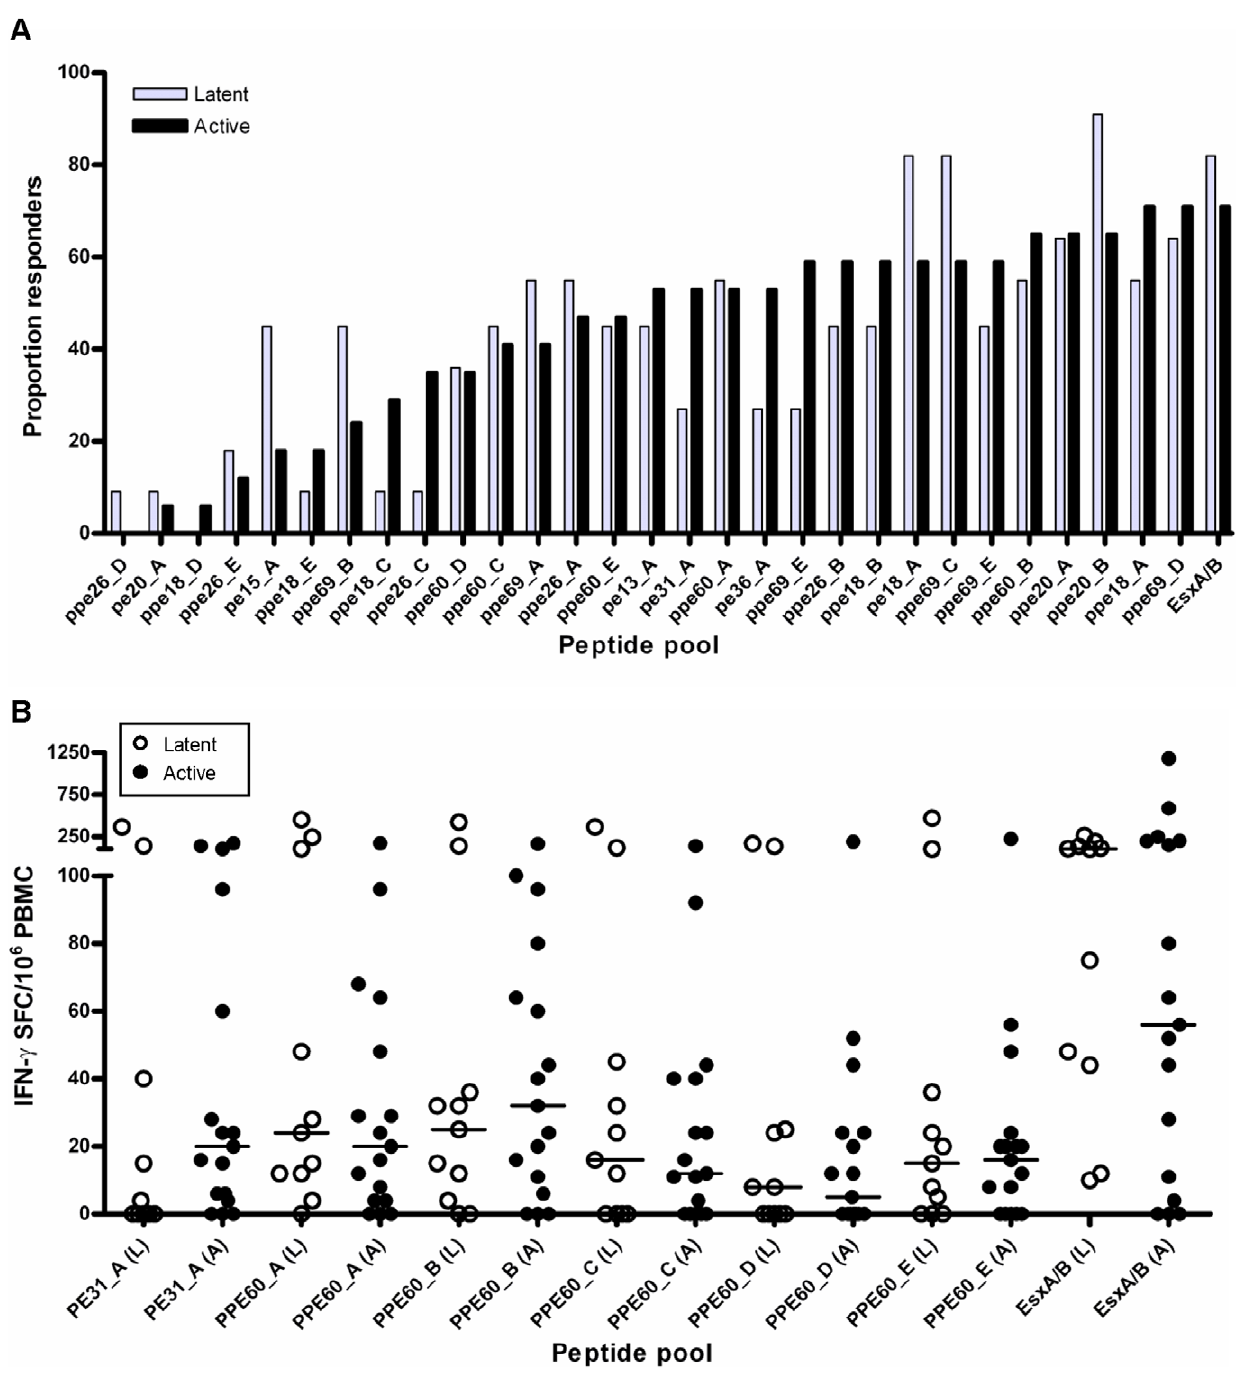
Figure 3. Immune responses to PE/PPE proteins in humans with active and latent infection. PBMC from M. tuberculosis -sensitized individuals were stimulated with PE/PPE peptide pools, and IFN- c producing cells were enumerated by ELISPOT. (A) Proportion responders to all PE/ PPE pools analyzed. Grey bars, individuals with latent infection; Black bars, individuals with active infection. (B) Number of IFN- c producing cells measured after stimulation with PE/PPE peptide pools. White symbols, individuals with latent infection; Black symbols, individuals with active infection. No statistically significant differences were observed between responses in individuals with latent and active infection for any of the peptide pools analyzed (as determined by Mann Whitney U test). Results for a representative set of pools shown, horizontal lines indicate median responses. doi:10.1371/journal.pone.0040890.g003 terminal peptide pools. For example, in the 3 representative examples shown in Figure 4 B–D, N-terminal peptide pools Analysis of bovine and human immune responses to PE/PPE elicited larger IFN- c responses, as measured by D OD 450 . We peptide pools highlighted a trend towards better recognition of N-